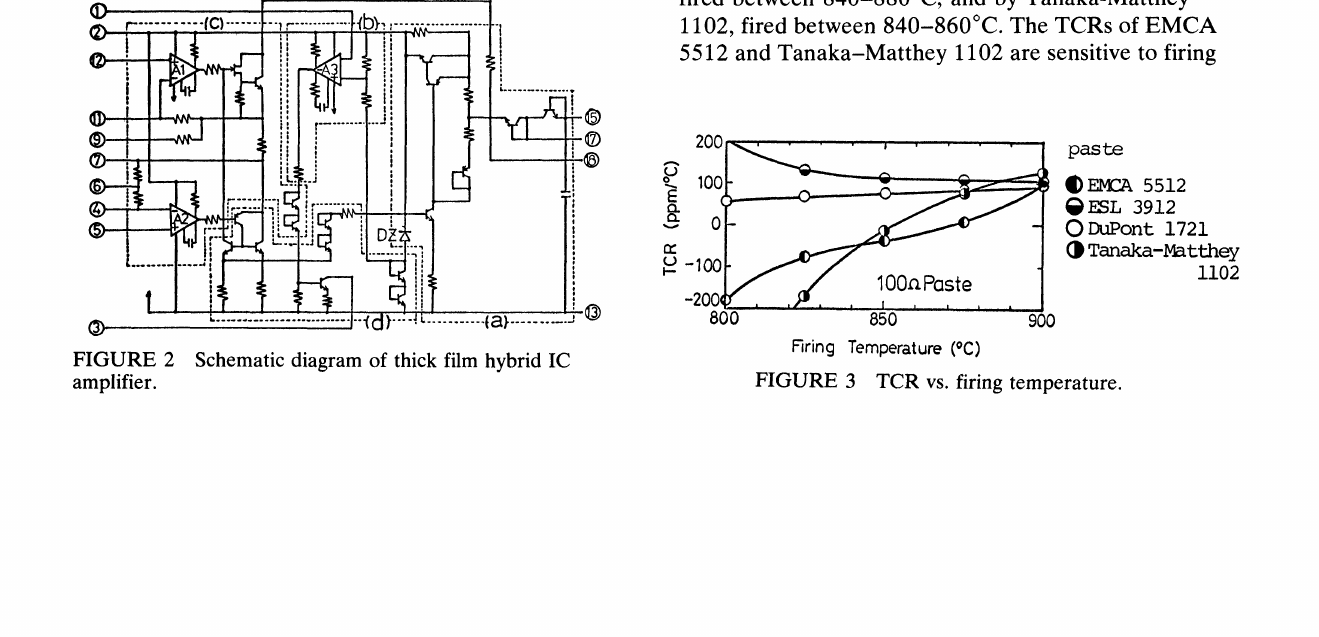
FIGURE 2 Schematic diagram of thick film hybrid IC amplifier. FIGURE 3 TCR vs. firing